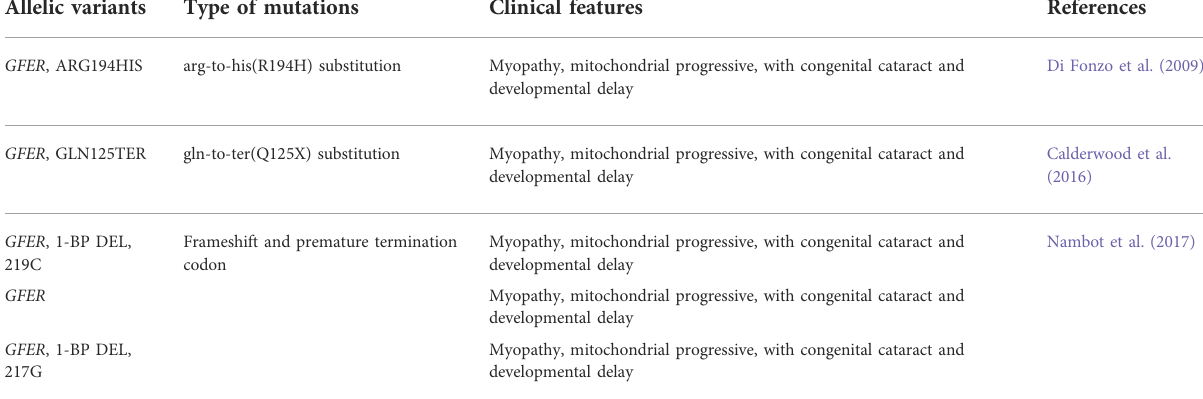
TABLE 1 Summary of human ALR